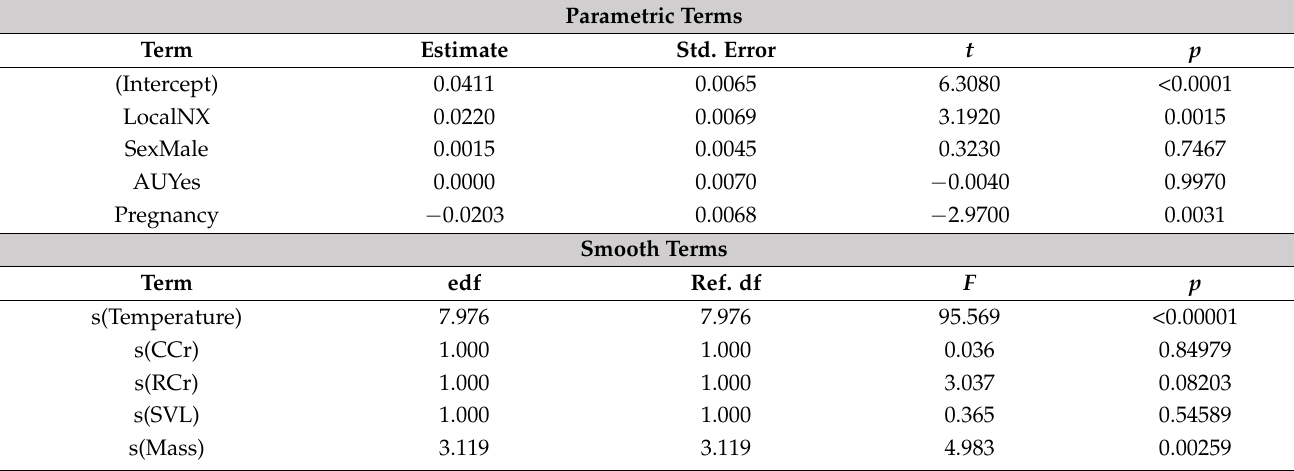
Table 2. Full generalized additive mixed-effects model (GAMM) relating predictors to locomotor performance (sprint speed) of the lizard Micrablepharus atticolus . AU: caudal autotomy (yes/no), CCr: total tail length, RCr: length of the regenerated portion of the tail, SVL: snout-vent length, NX: Nova Xavantina, edf: expected degrees-of-freedom.